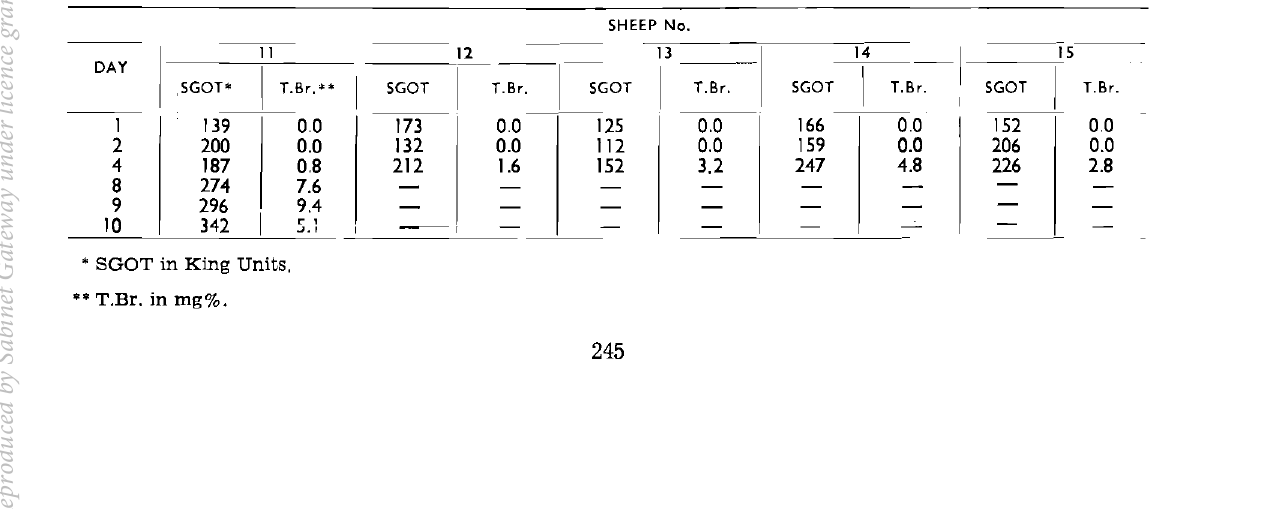
Table 2: EFFECT OF DOSING PURE CULTURES OF P. LEPTOSTROMIFORMIS ON BLOOD SGOT AND T.BR.